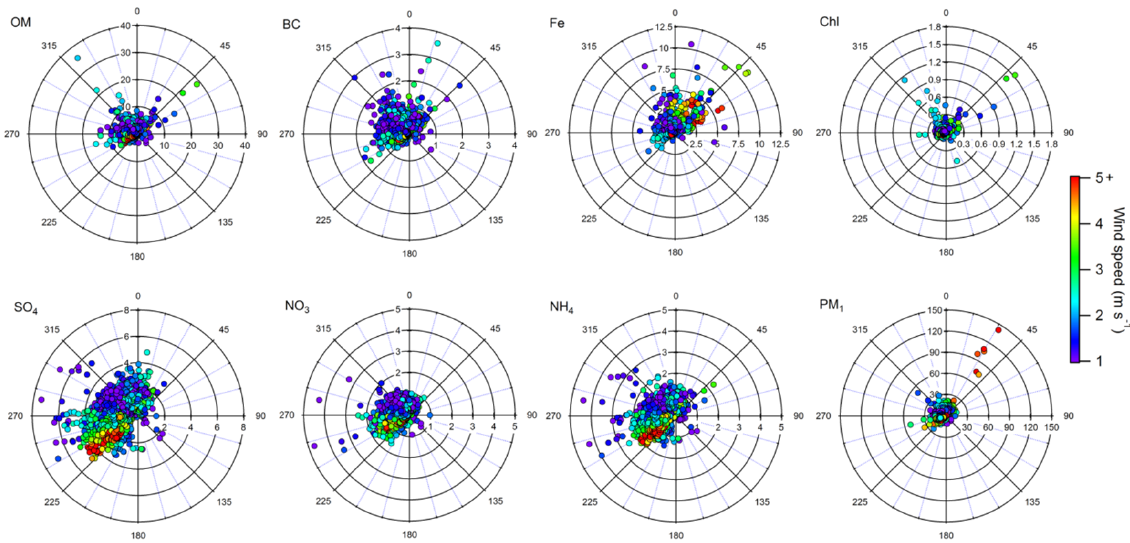
Figure 8. Pollution rose plots of OM, BC, Chl, Fe, SO 4 , NO 3 , NH 4 and total PM 1 for the whole IOP-1, with concentrations (µgm − 3 ) as radius and colored by wind speed (measurements less than 1ms − 1 in